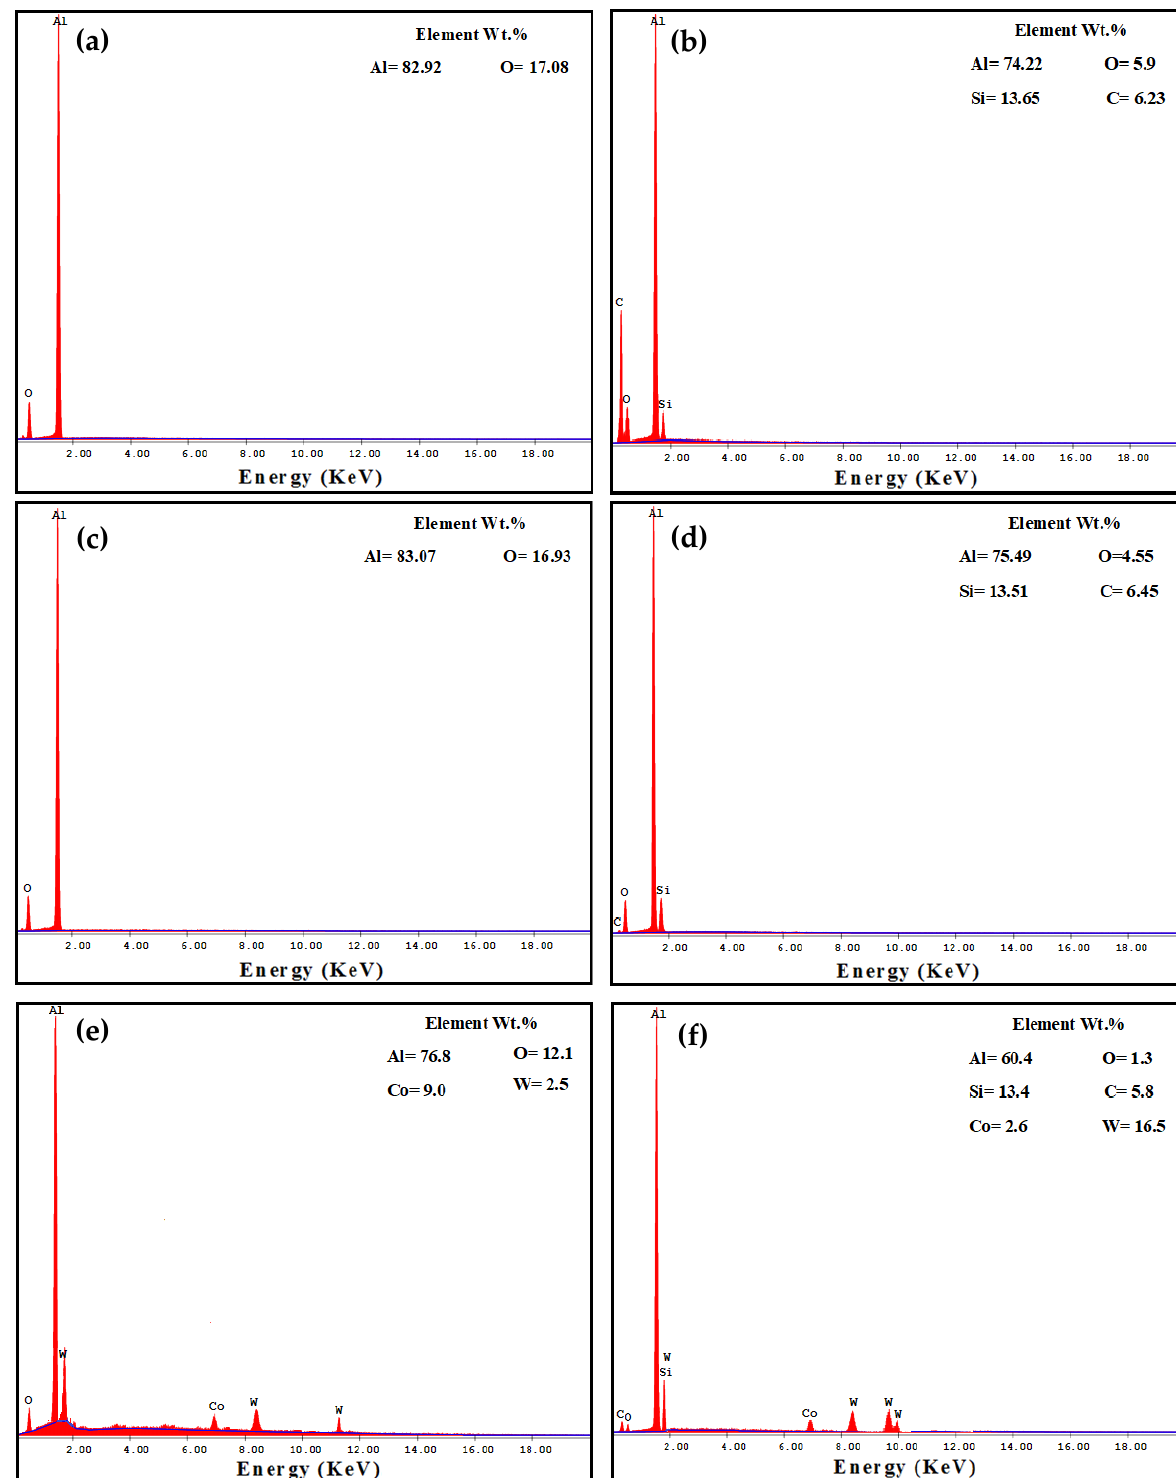
Figure 11. EDS analysis of the worn surface morphology of ( a ) PM Al-20% Al 2 O 3 , ( b ) PM Al-20% SiC, ( c ) HPT-processed Al-10% Al 2 O 3 , ( d ) HPT-processed Al-10% SiC, ( e ) HPT-processed Al-20% Al 2 O 3 , and ( f ) HPT-processed Al-20% SiC samples obtained under an applied load of 20 N and a sliding distance of 315 m.